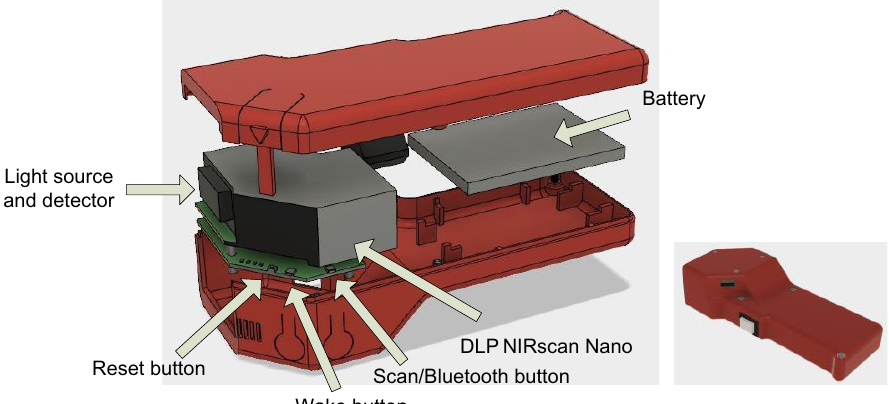
Fig. 1. Components of portable